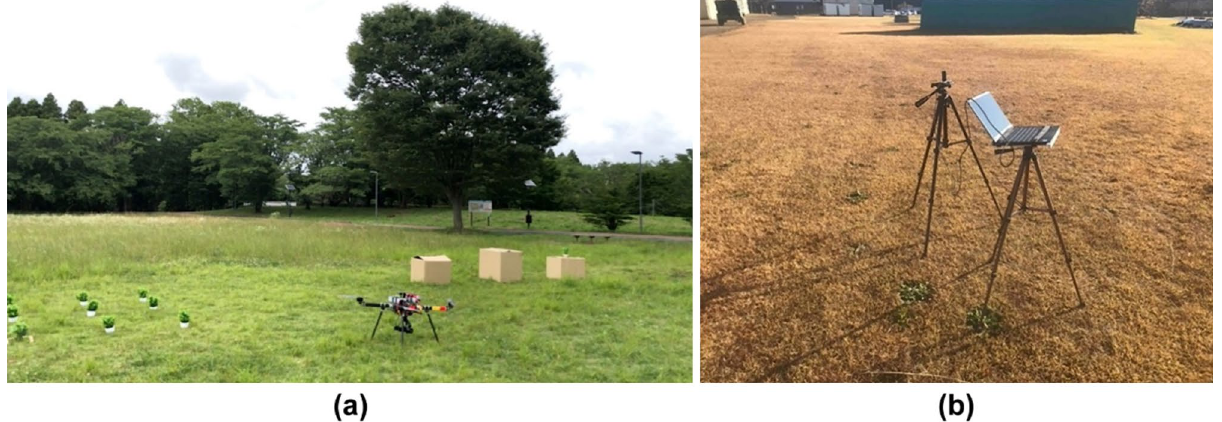
Figure 5. Environment of first experiment: ( a ) test field and ( b ) base station.